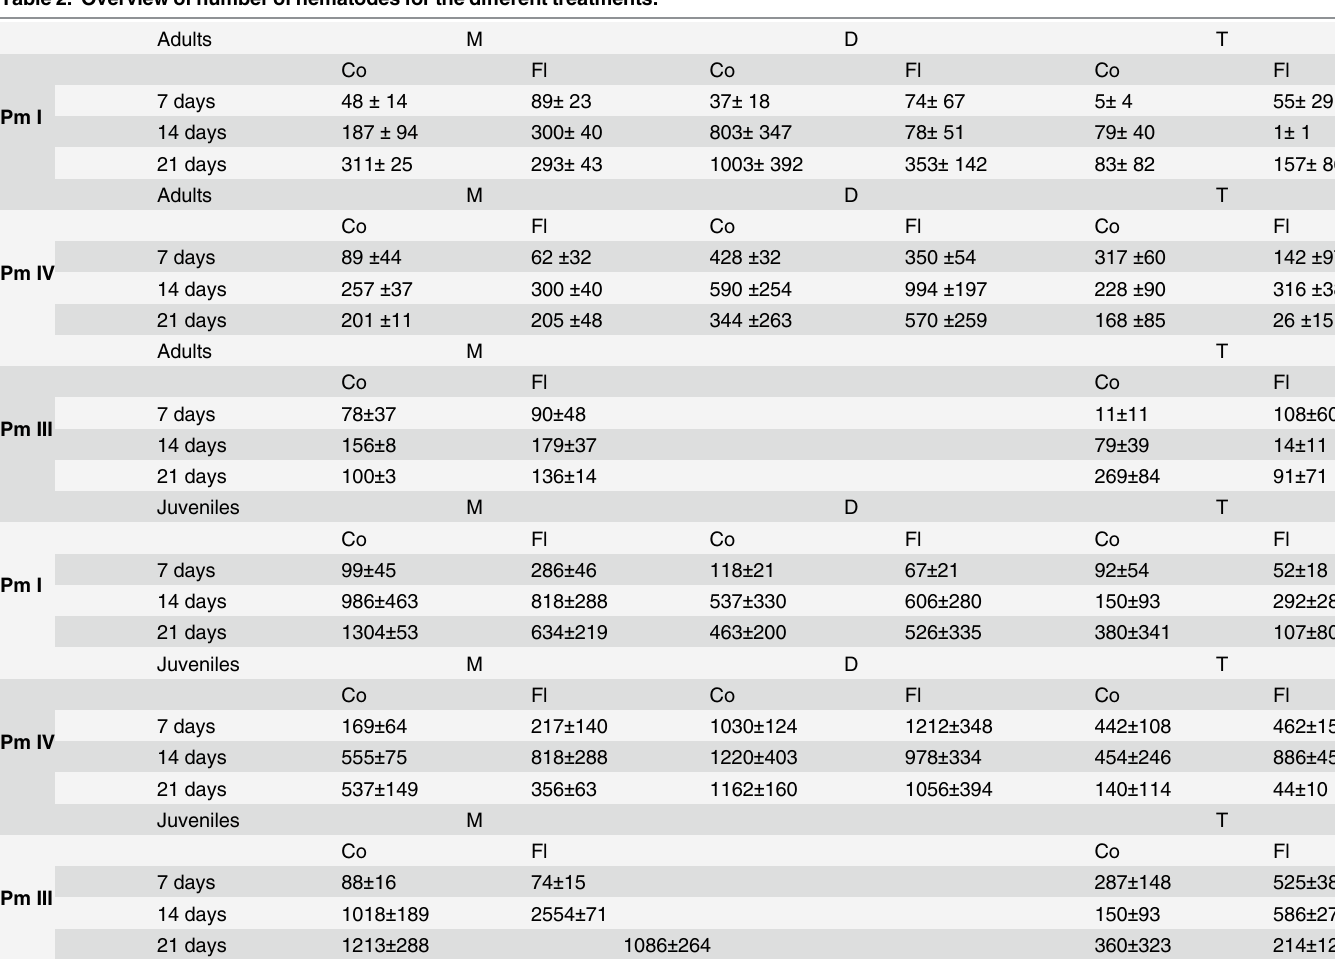
Table 2. Overview of number of nematodes for the different treatments.